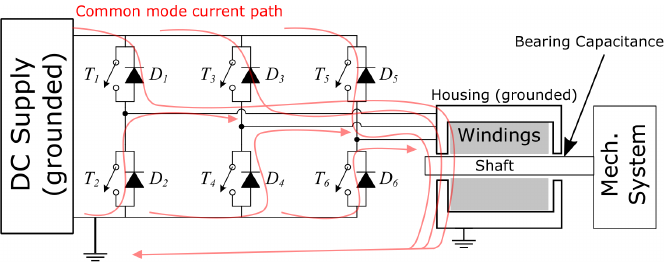
Figure 1. Common-mode current path in an electrical drive